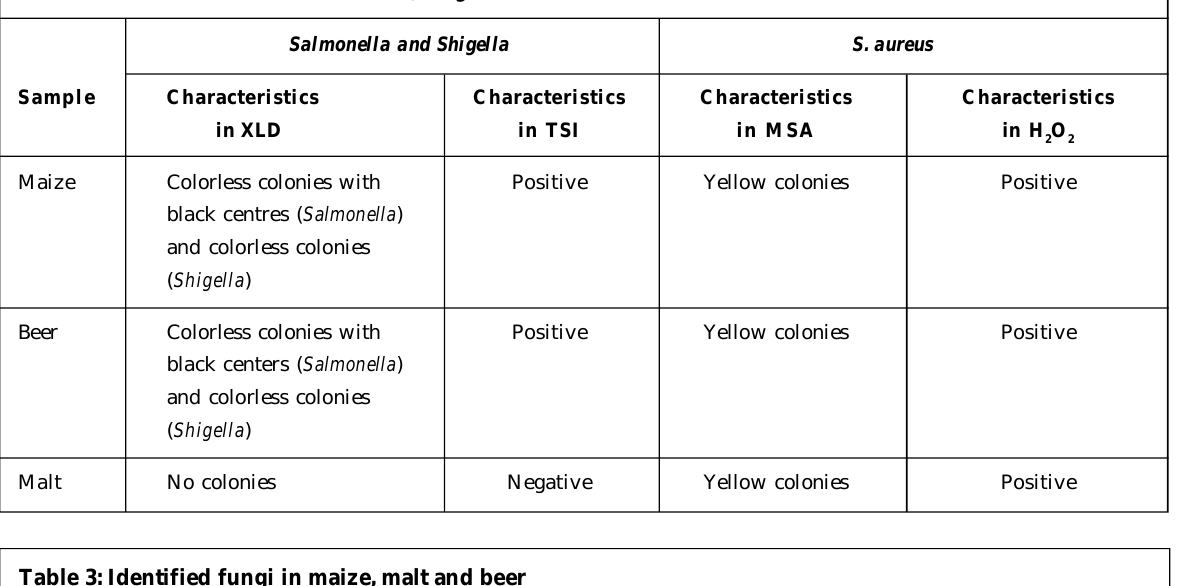
Table 2: Determination of Salmonella , Shigella and S. aureus